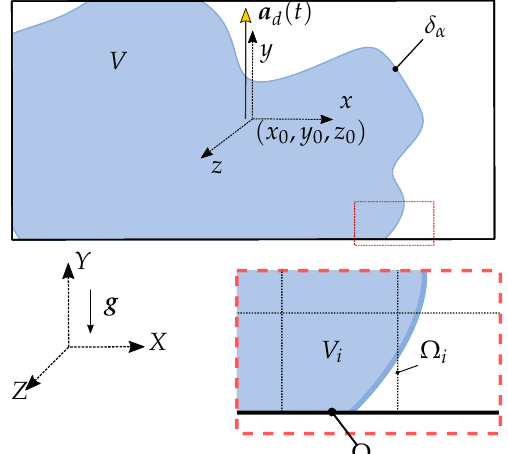
Figure 3. Schematic illustrating a non-inertial simulation domain in reference frame x , y , z , undergo- ing linear acceleration a d . The simulation domain is represented by volume V with bounding surface Ω . There is a two-phase flow inside the domain, with δ α the interface between